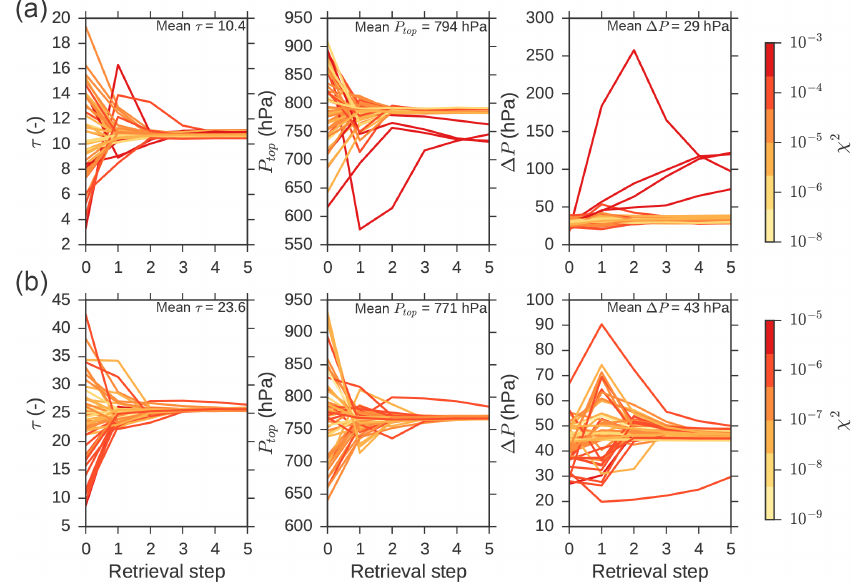
Figure 7. Example iteration in retrieved cloud properties for synthetic micro-window retrievals for test cases with cloud optical depth near 10 (a) and 25 (b) . Each line represents the iterations through 1 of the 50 sample retrievals. The lines are coloured according to their χ 2 values; note the separate colour bars for the top and bottom rows with larger χ 2 for the top